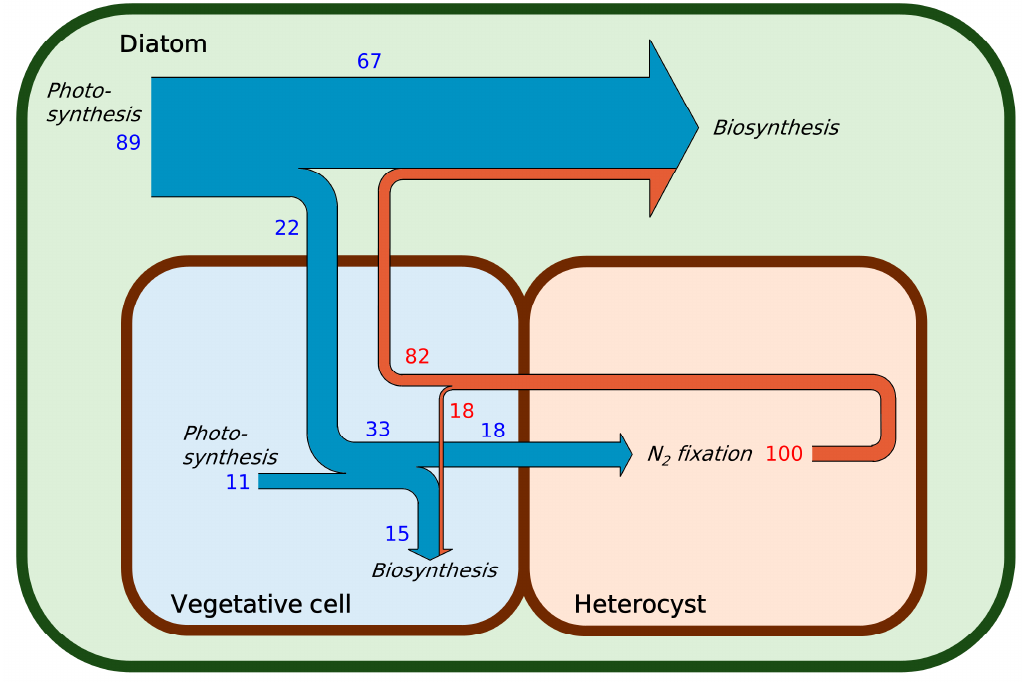
Figure 3. Simulated C (blue arrows) and N (brown arrows) exchanges between the diatoms ( Hemiaulus ) and trichomes ( Richelia ). The width of the arrows represents the relative magnitude of fluxes in mass. Blue numbers represent percentages of C fluxes (here, 100 indicates total sources and sinks of C in the symbiosis; e.g., 89 on the top left means 89% of photosynthesis in the symbiosis is done by a diatom) and red numbers are percentages of N (separate from those of